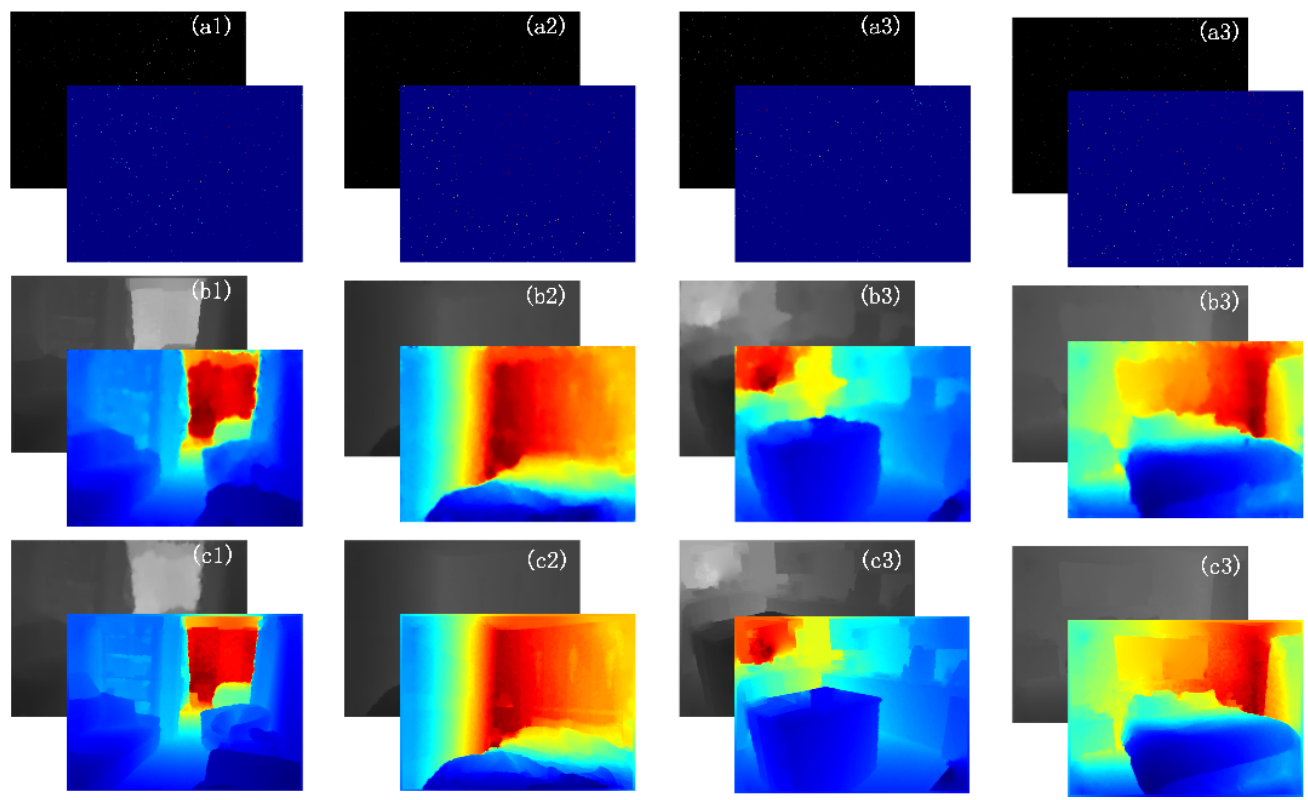
Figure 6. The complete results of our network on NYU. ( a ) is the input sparse depth image. ( b ) is the completed depth image we output. ( c ) is the ground truth. Table 2. Comparisons to other methods on NYU. The bold numbers are the best.